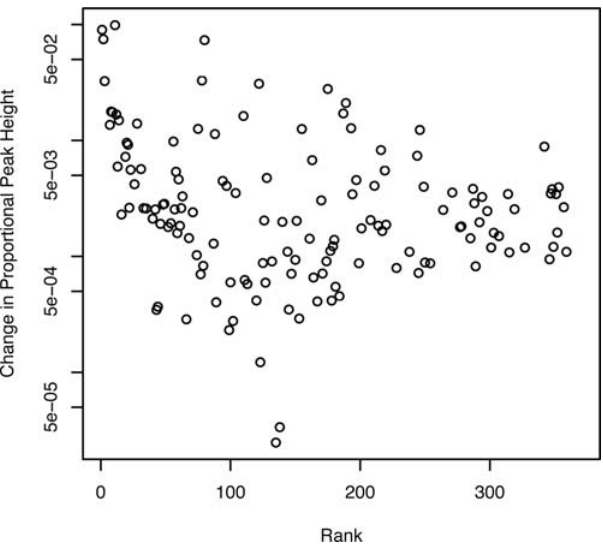
Figure 4. Comparison of differences in relative peak height between composite TRFs from GC-TRFLP and matching TRFs from TRFLP which shows that variation in peak height between TRFLP and GC-TRFLP increases with increasing peak height. Comparison is ordered based on peak rank in composite GC-TRFLP.